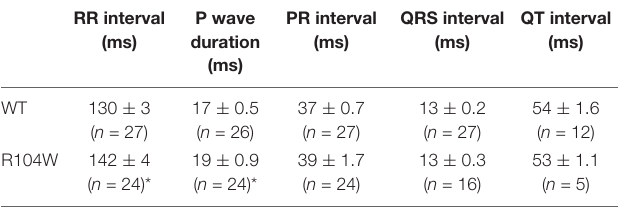
TABLE 3 | Electrocardiographic